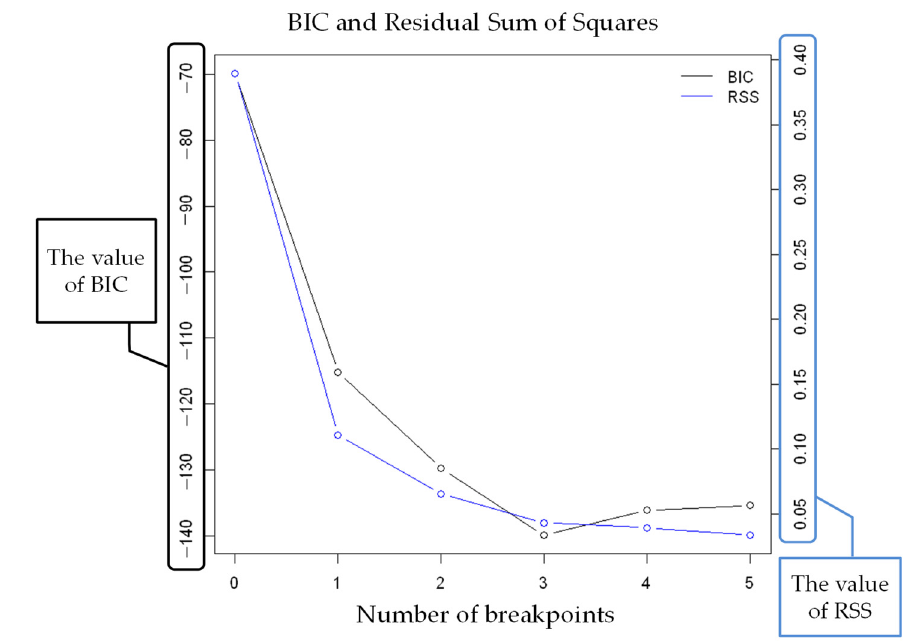
Figure 10. The number of breakpoints (RQ). The results of strucchange results of RQ (subject K) after smoothing are shown in Figure 11. The vertical solid line shows the AT by the respiratory metabolic apparatus. The vertical dashed line indicates the change point by strucchange, and the red H-shape indicates the confidence interval of strucchange. The confidence intervals were calculated to be within 95%.